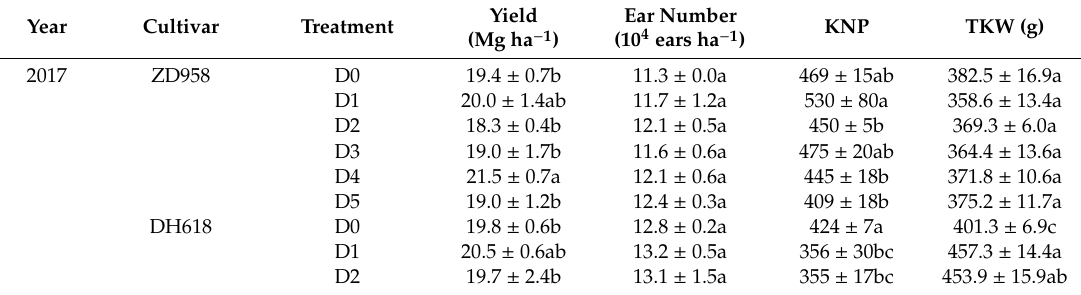
Table 1. Yield and yield components of ZD958 and DH618 under di ff erent treatments in 2017 and